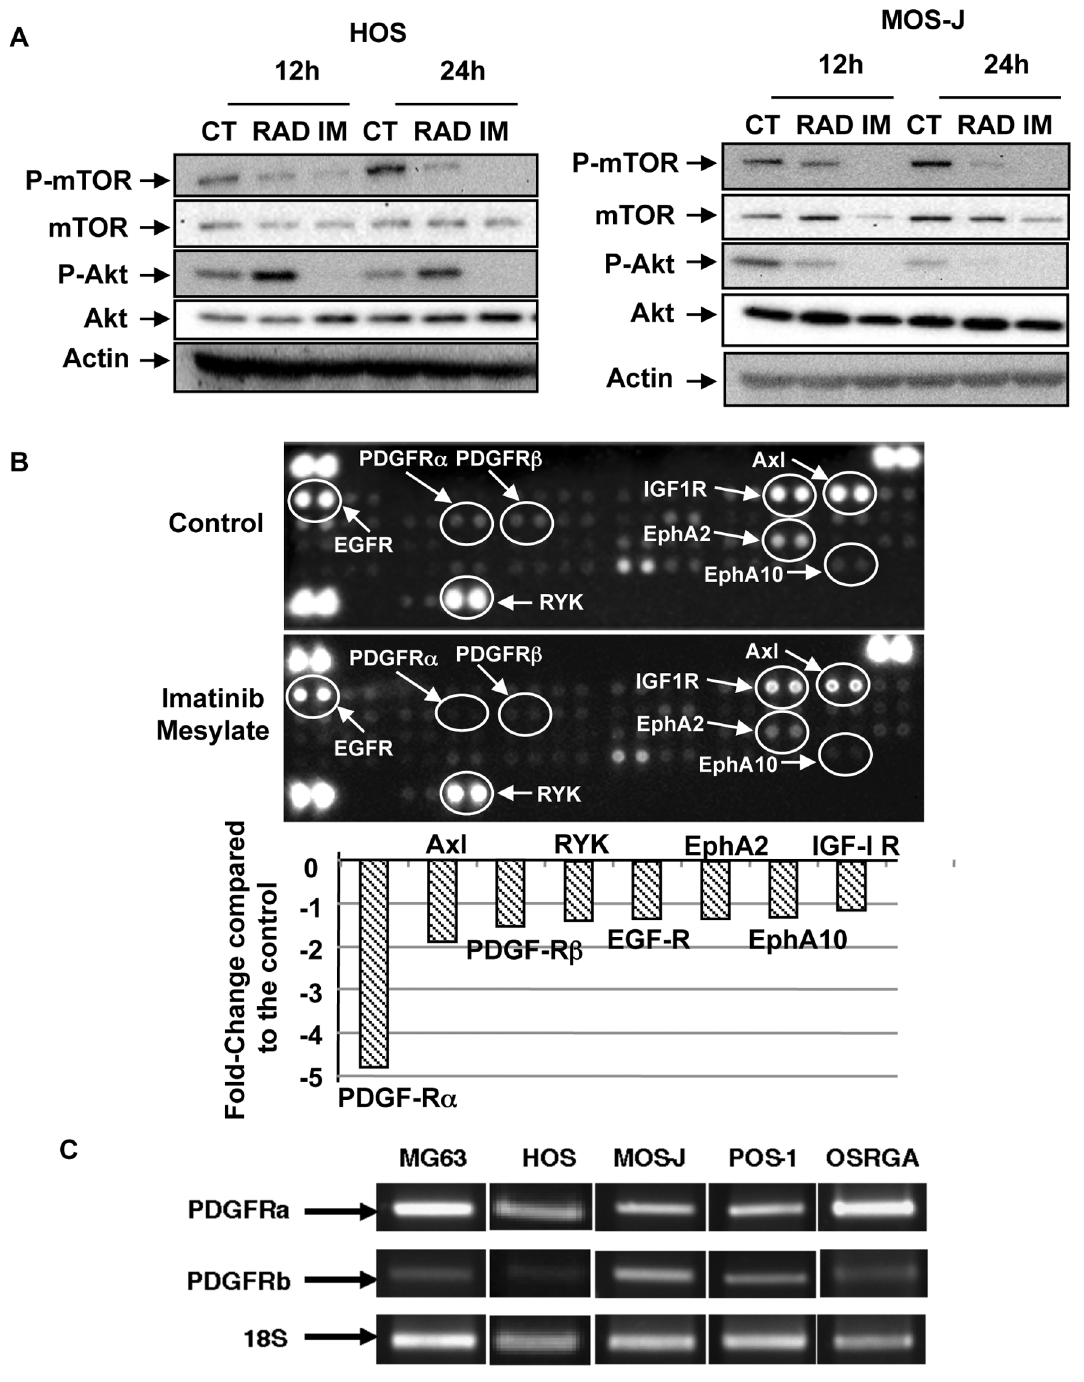
Figure 7. Imatinib mesylate inhibits AKT/mTOR signaling pathway in osteosarcoma cells and activates ERK1/2 phosphorylation: PDGFR a , a key target of osteosarcoma cells. Human, mouse and rat osteosarcoma were treated with various doses of imatinib mesylate to analyse the effects of the drug on intra-cellular signaling pathways. ( A ) Imatinib mesylate inhibits mTOR and Akt phosphorylation in human HOS and mouse MOS-J cells. RAD001 named everolimus (RAD), a mTOR inhibitor was used as a positive control. ( B ) Human Phospho-receptor tyrosine kinase array Kit was used to identify the molecular targets of imatinib mesylate. (C) Expression of PDGFR a and PDGFR b analyzed in human, mouse and rat osteosarcoma cells by semi-quantitative RT-PCR. addition, while all cell lines were sensitive to this drug, PDGFR a was expressed by all cell lines in contrast to PDGFR b . Our data are in agreement with the data obtained recently by Kitagawa